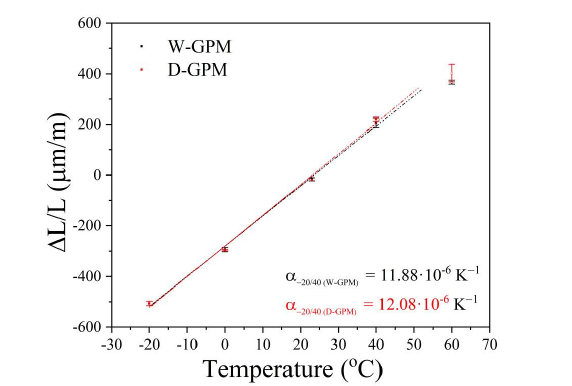
Figure 9. Thermal expansion Δ L/L depending on temperature and coefficient of thermal expansion α ‐ 20/40 . Table 4. Coefficient of thermal expansion α in different temperature ranges and coefficient α ‐ 20/40 according to EN 1770 [50] by regression analysis as well as its coefficient of determination R² W ‐